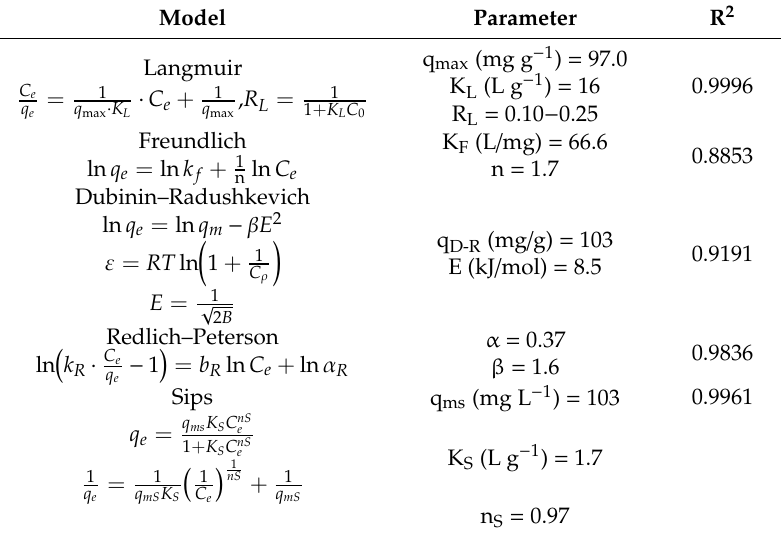
Table 1. Adsorption models and parameters investigated in the present study. Model